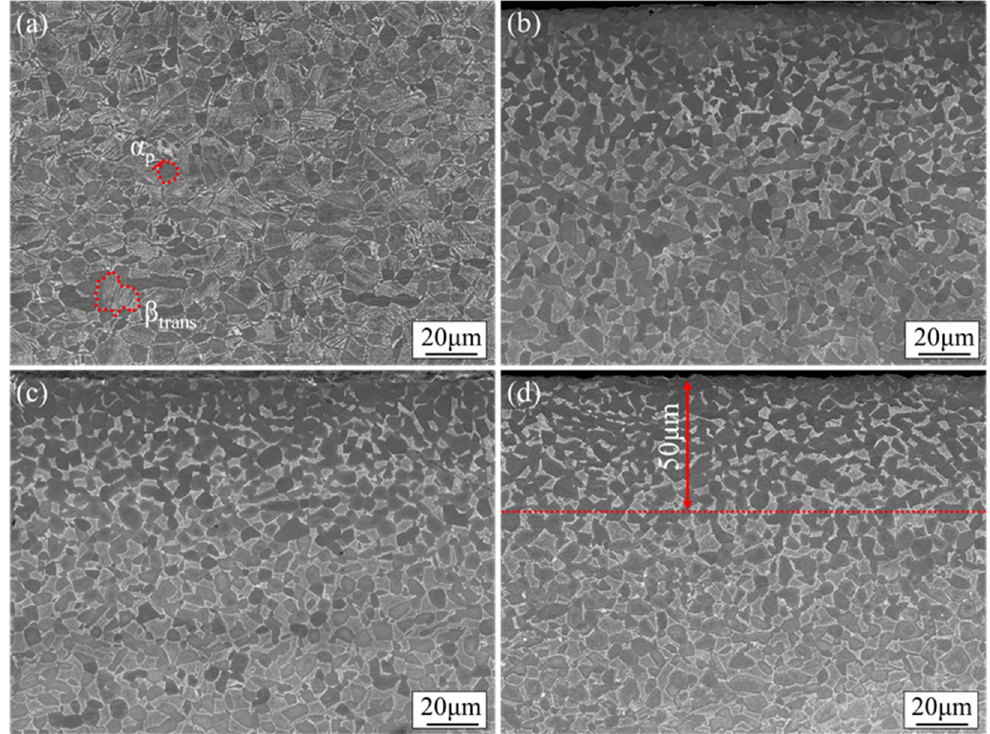
Figure 3. SEM images of microscopic morphology after diffusion and aging heat treatment: ( a ) matrix of NPO specimen, ( b ) surface layer of PO10 specimen, ( c ) surface layer of PO20 specimen, and ( d ) surface layer of PO60 specimen. Table 4. The volume fraction of α p and β trans phases within 50 μ m of the surface layer for different specimens.